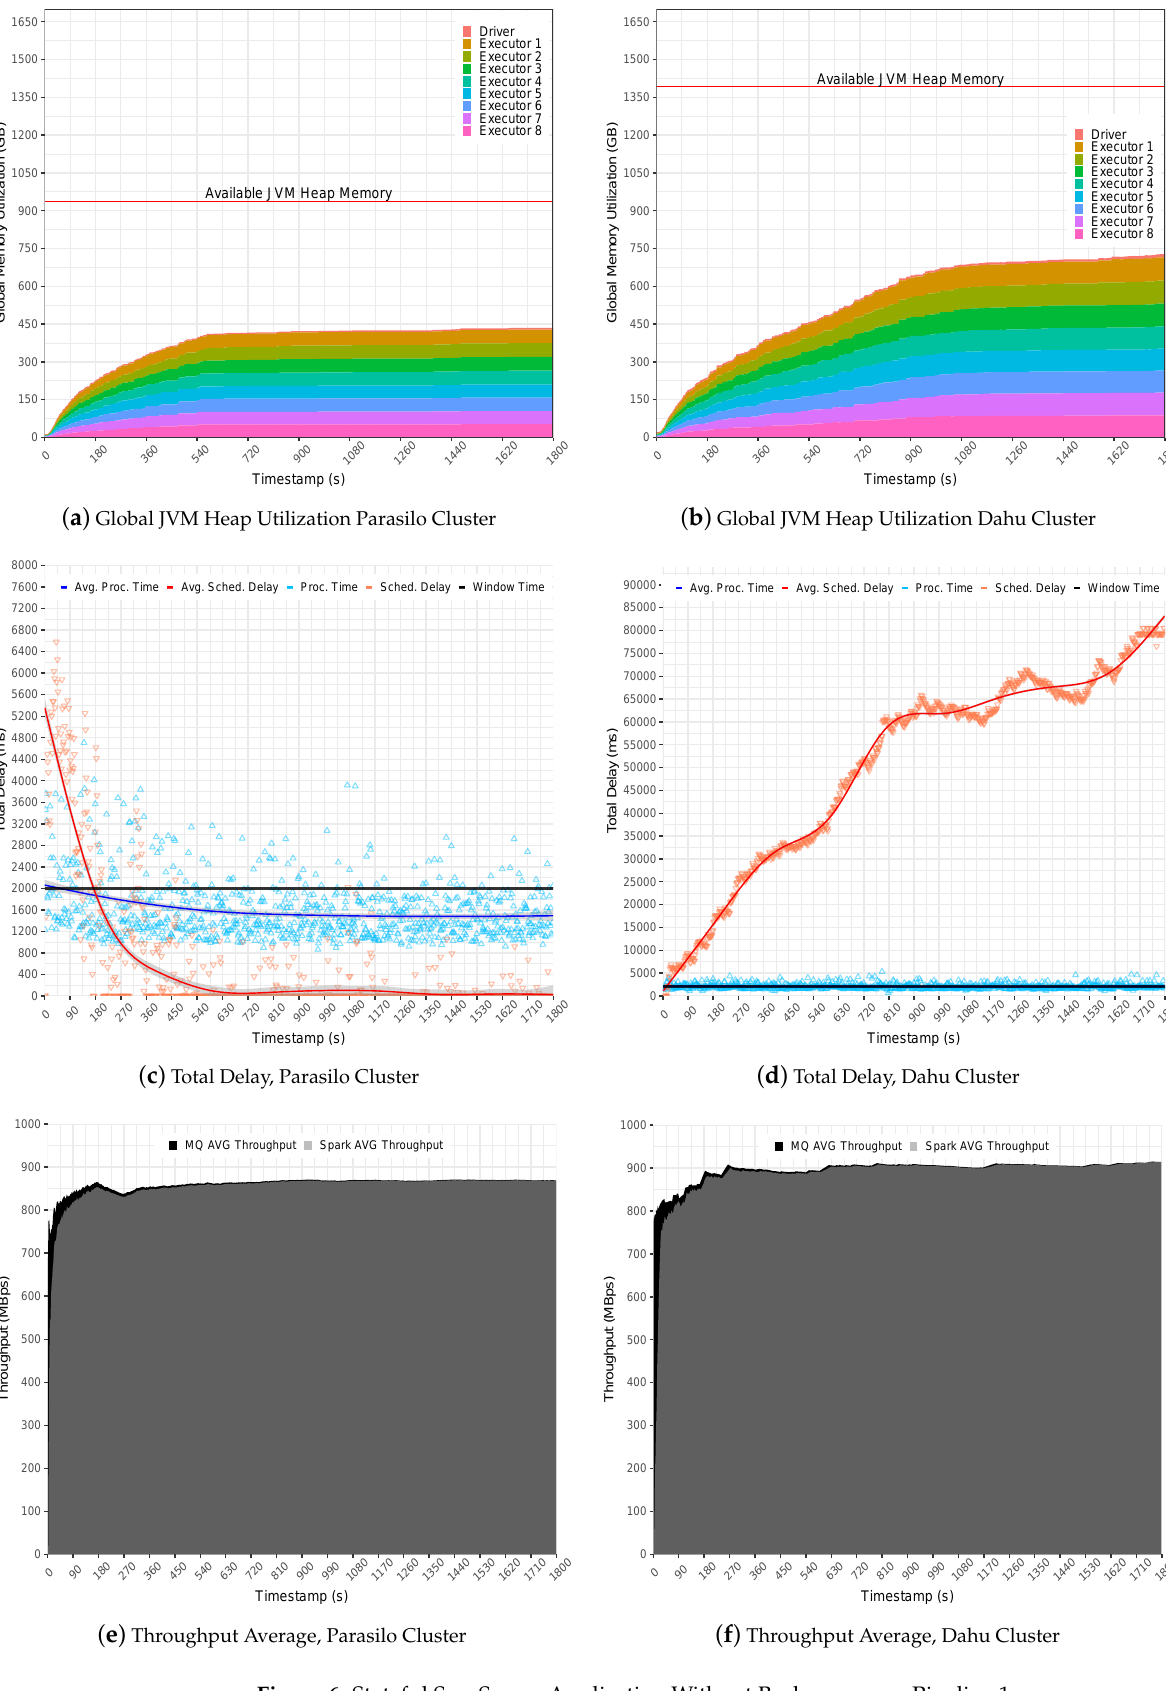
Figure 6. Stateful SumServer Application Without Backpressure—Pipeline